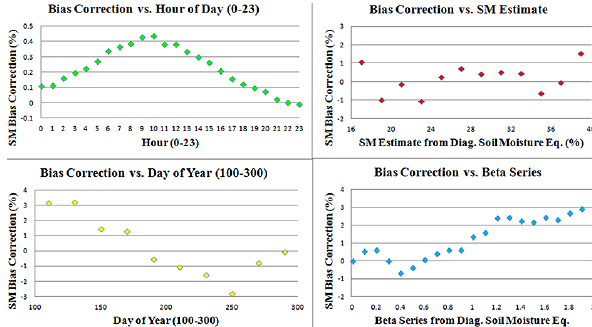
Figure 8. Bias correction analysis, SCAN site 2068 (ISCJ, plains, silty clay